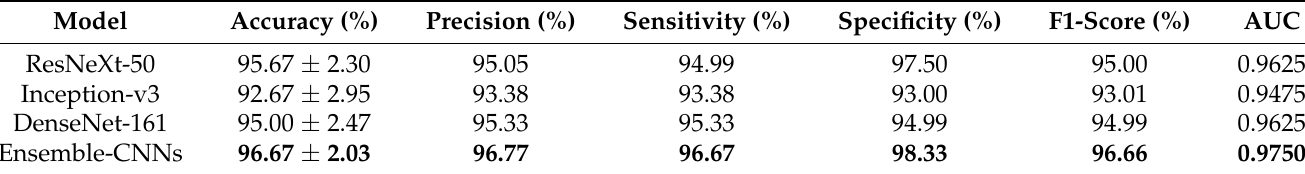
Table 7. The experimental results for the validation data of our proposed three-class COVID-19 database. Model